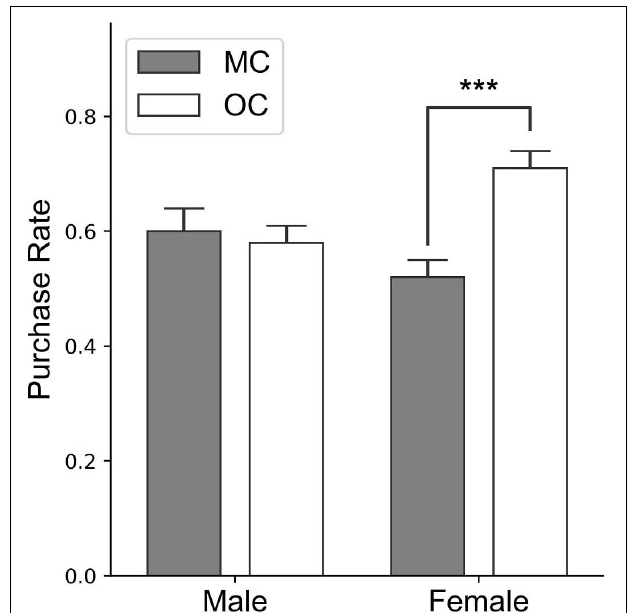
question with a six-point scale (1 = not at all, 6 = very much; see Supplementary Material ).